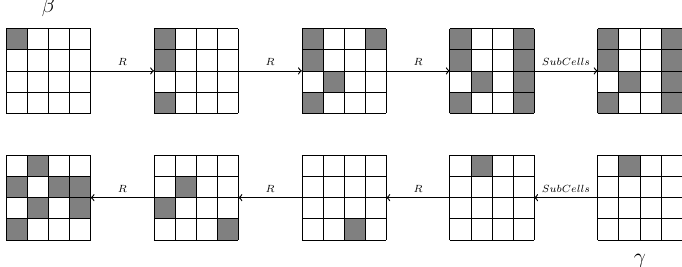
Figure 4: An example of 4-round E m for SKINNY , the two differential characteristics are given in truncated notation (gray denotes an active nibble, white denotes an inactive nibble), the above one is used for encryption and the below one is used for decryption.